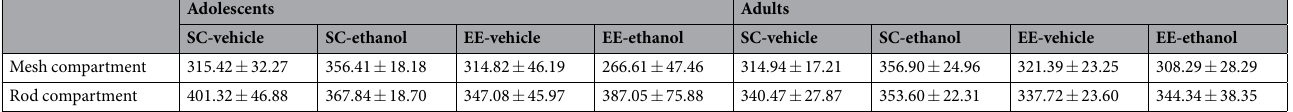
Table 1. Time spent (s) during the habituation phase of the conditioned place preference procedure, in the mesh or rod compartments, in adolescent and adult mice as a function of rearing condition (standard [control] conditions and environmental enrichment; SC and EE groups, respectively) and treatment during CPP training (vehicle or ethanol). The data are presented as mean ± SEM.